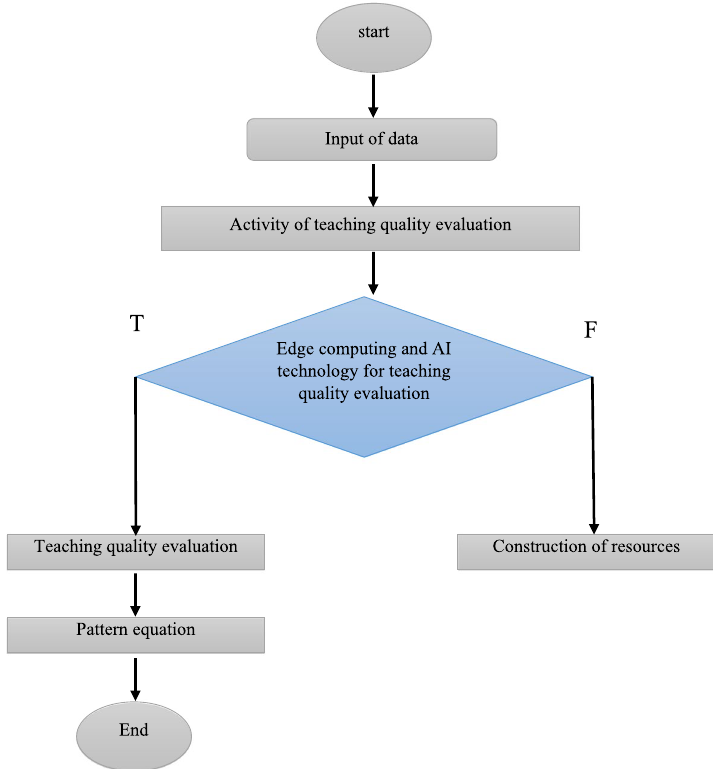
Fig. 7 Flow diagram of the AI method’s evaluation method and edge